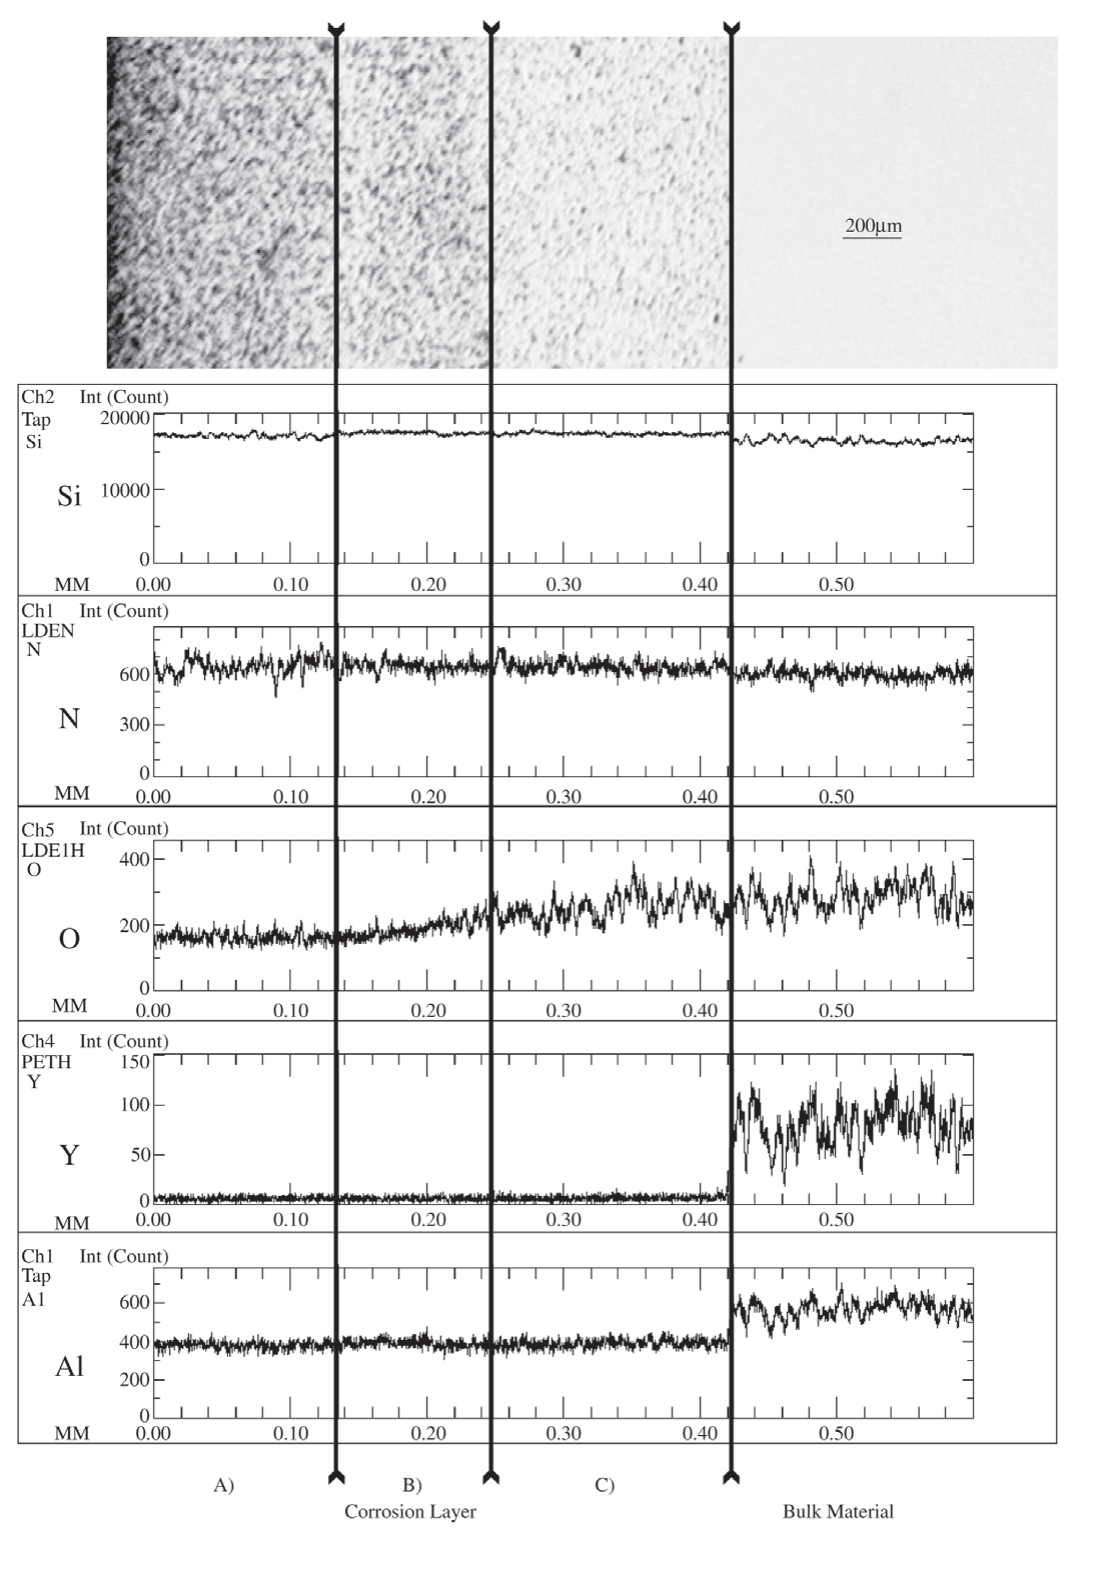
Figure 6. Linescan my microprobe across the corrosion layer in comparison with the optical mi crograph (top) after 43